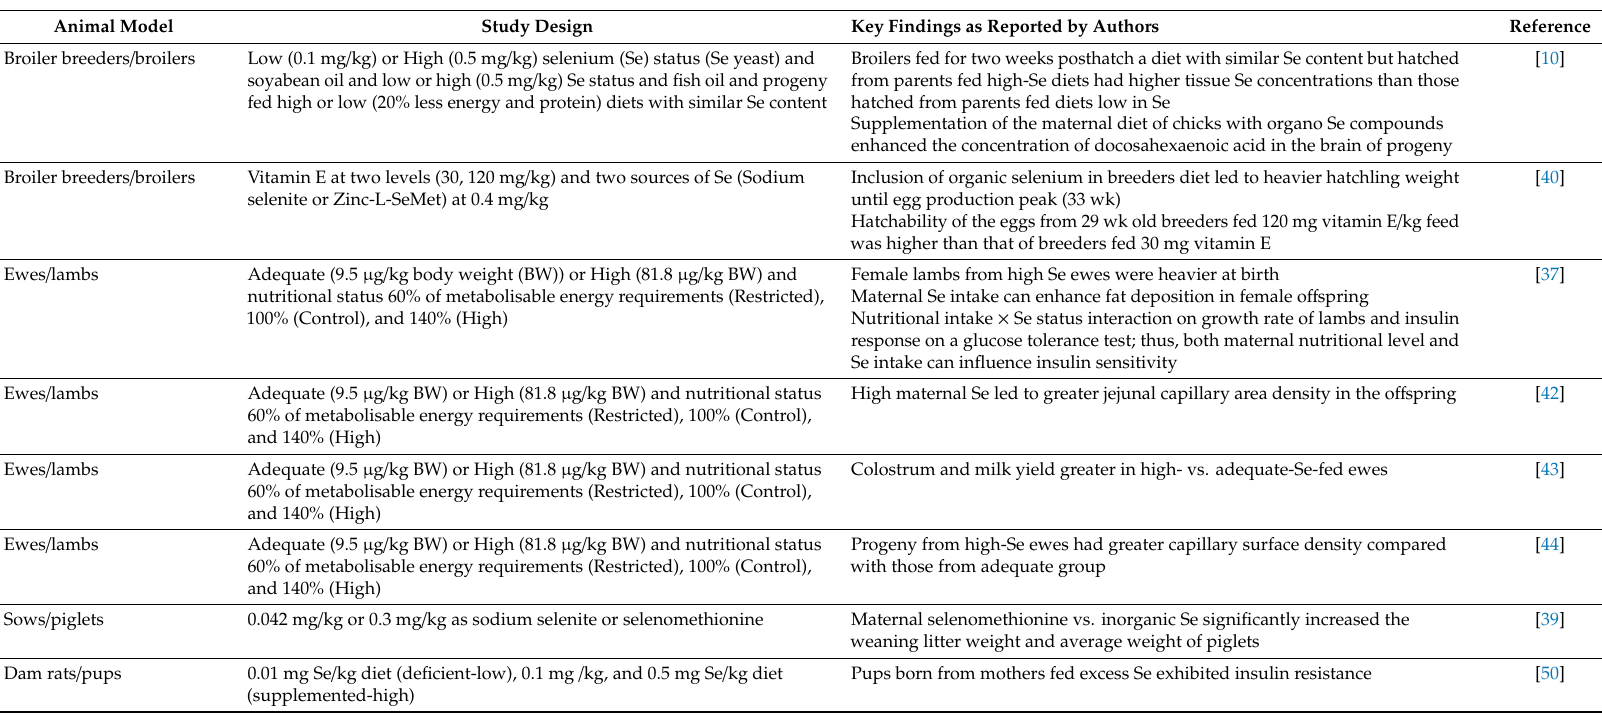
Table 1. A summary of selected studies describing the combined e ff ects of maternal plane of nutrition and selenium status on